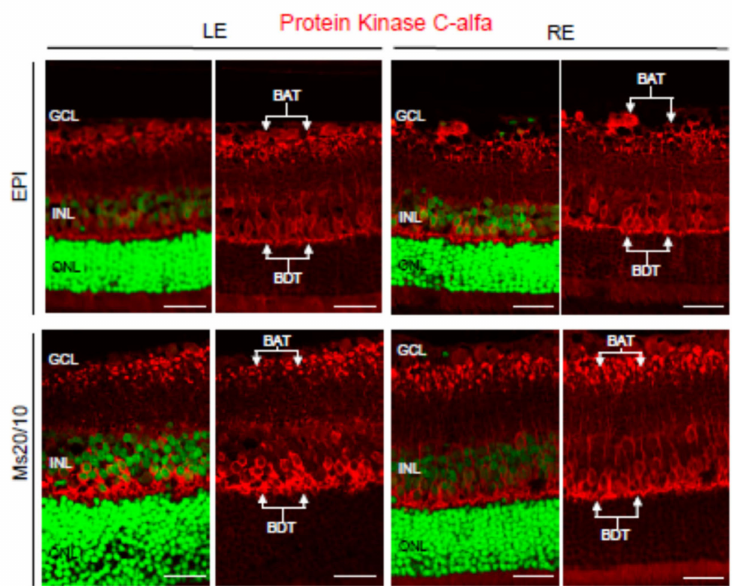
Figure 11. Calcium-dependent protein kinase C alfa (PKC α ) expression in the glaucomatous EPI and Ms20/10 models. Representative images showed the location and total volume of PKC α observed in the retinas. GCL: ganglion cell layer; INL: inner nuclear layer; ONL: outer nuclear layer; LE: left eye (control); RE: right eye (treated); BAT: bipolar axon terminals; BDT: bipolar dendrite terminals. Scale bar: 34.24 µ m.